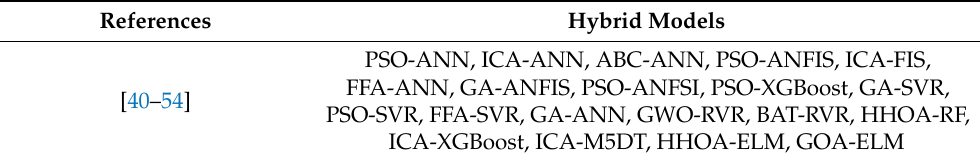
Table 2. Hybrid Models developed and applied to predict ground